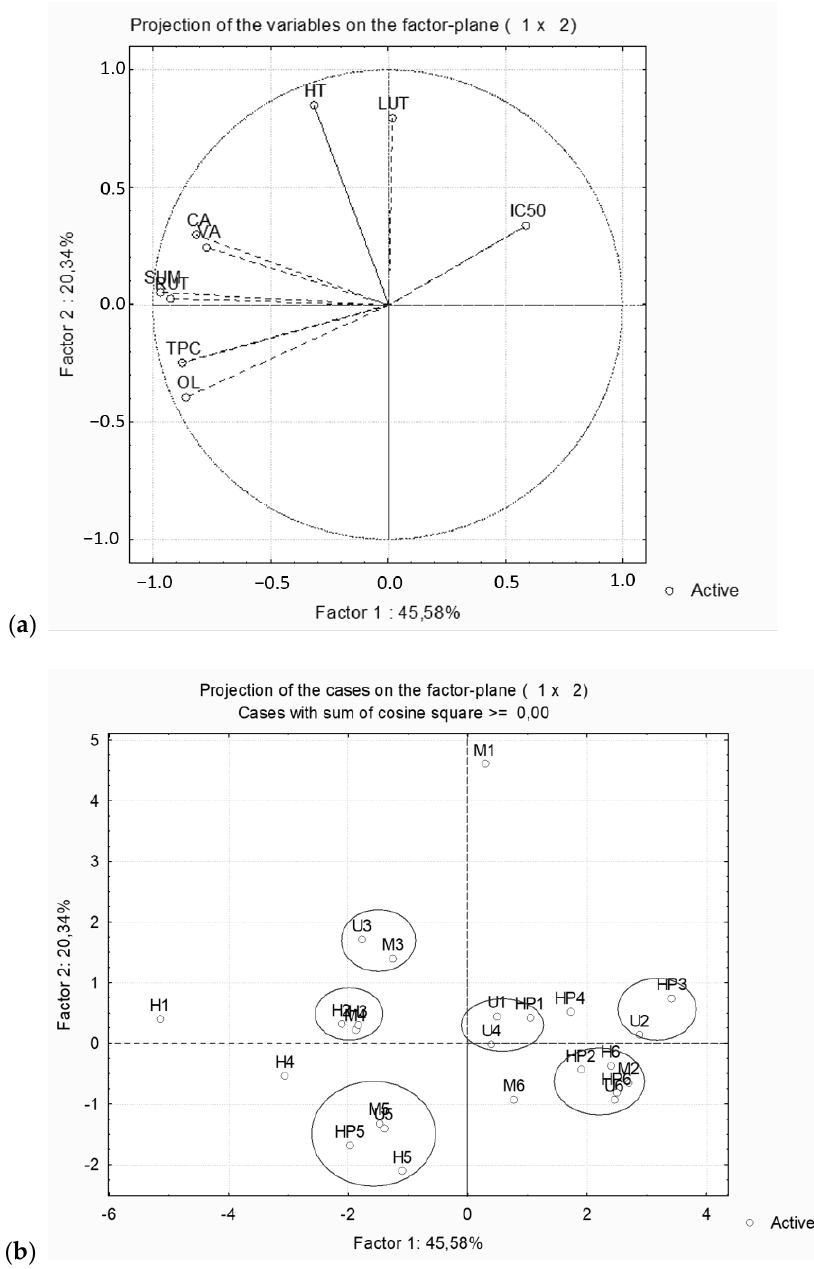
Figure 3. Principle component analysis of the dependent variables of the studied extractions ( a ) and of the samples with NADES (1 = CCA, 2 = CMA, 3 = CLA, 4 = GGL), ethanol:water 70% v / v (5) and water (6) as solvents, under intense conditions for each extraction method (M = MAE: 60 °C/30 min, U = UAE: 60 °C/30 min, H = HAE: 60 °C/12,000 rpm and HP = HHPAE: 600 MPa/10 min) ( b ).